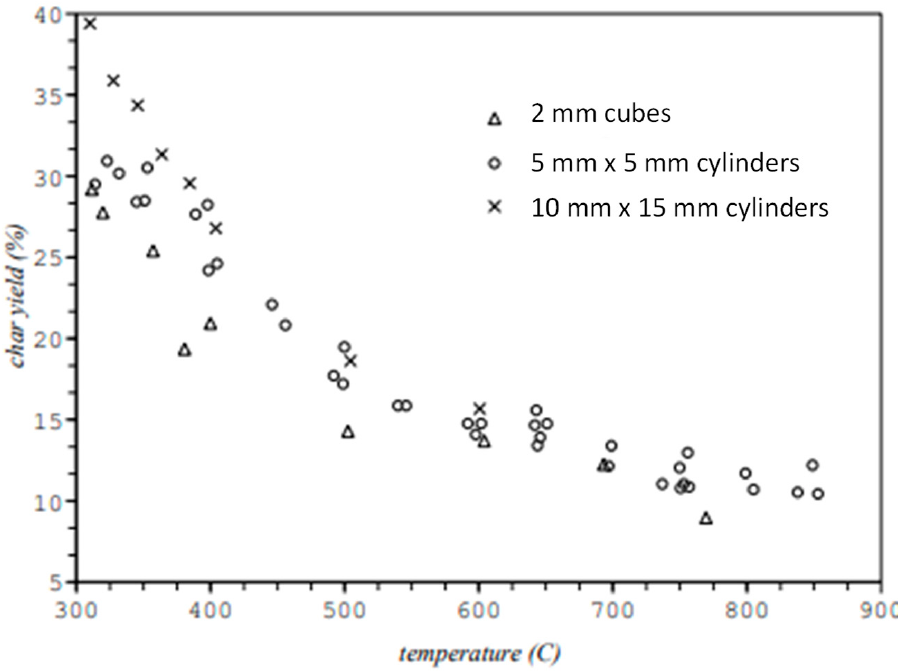
Figure 5. Effect of particle size and temperature on char yield during pyrolysis of thermally thick particles. (Reprinted from ref. [26].)